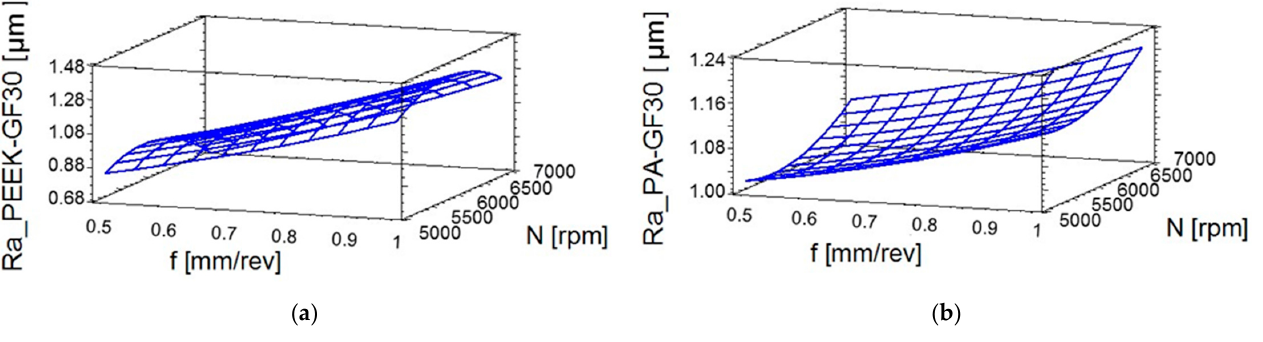
( b ) Figure 6. Standardized Pareto chart for diameter variation, at a 90% confidence level: ( a ) standard- ized effect for Δ D_PEEK-GF30 [dimensionless] and ( b ) standardized effect for Δ D_PA66-GF30 [di- mensionless]. For the PA66-GF30 composite, the differences between the pairs were statistically significant at a 95% confidence interval, according to Tukey’s HSD test, and with values of − 0.0467 (pair 0.5–0.75), − 0.1144 (pair 0.5–1), and − 0.0678 (pair 0.75–1) for f, and with values of − 0.0011 (pair 5000–6000), − 0.0667 (pair 5000–7000), and − 0.0656 (pair 6000–7000) for N. Although a specific model for Δ D prediction has not been found, Δ D values met high tolerance requirements after cryogenic drilling and within the considered range. The results of interaction between N and f in diameter deviation is shown in Figure 7a–d.